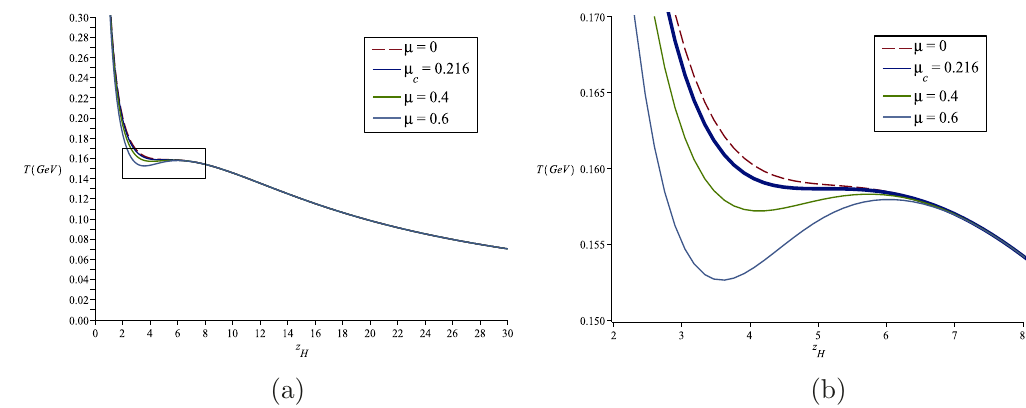
Figure 2 . (a) The black hole temperature vs. horizon at different chemical potentials. We enlarge the phase transition region in (b) to display the detail structure. For µ > mu c , the temperature becomes multi-valued that implies a first order phase transition. The transition temperature can be determined by calculating the black hole free